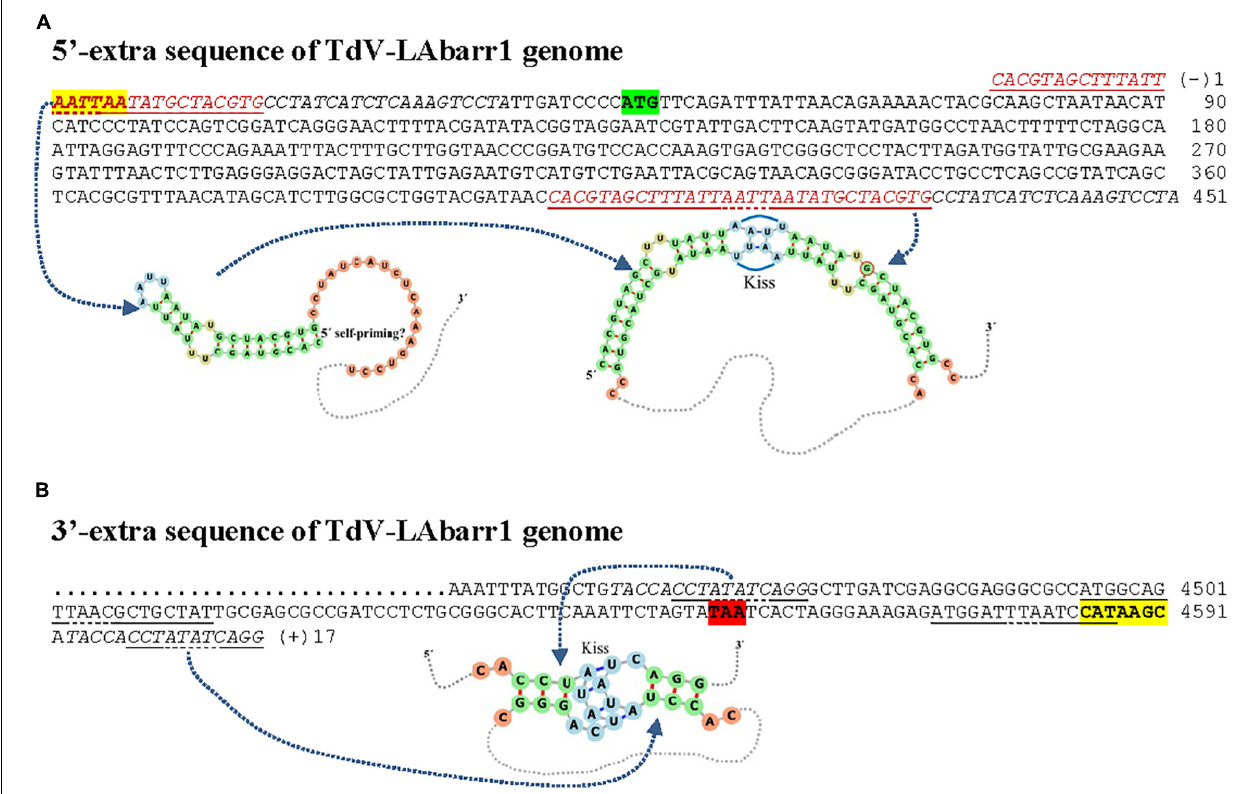
FIGURE 4 | cDNA of 5 (cid:48) -extra (A) and 3 (cid:48) -extra (B) sequences, and proximal canonical sequences of TdV-LAbarr1 genome from T. delbrueckii EX1180. The 5 (cid:48) -AATTAA and CATAAGC-3 (cid:48) ends of canonical sequences are in boldface and yellow highlighted. The protein synthesis initiation and stop codons of Gag-Pol are shaded in green and red, respectively. Nucleotides of palindromic sequences are shown in red. Duplicated sequences in each virus are in italics. Stem loops are underlined, and unpaired nucleotides of each loop are dot underlined. The secondary RNA structure of possible 5 (cid:48) stem loops and kissing stem loops are shown at the bottom of the